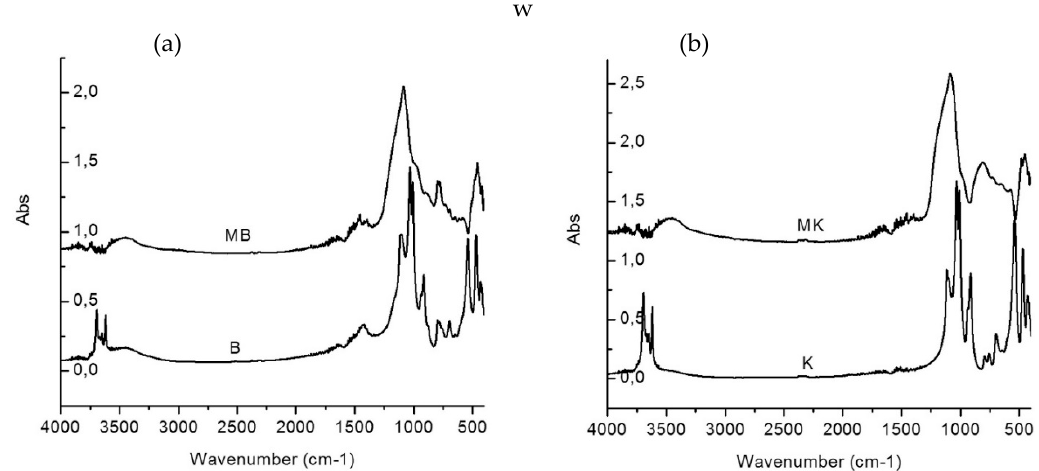
Figure 6. FTIR Spectra of ( a ) kaolin and ( b ) ceramic waste; MB = calcined ceramic waste, B = ceramic waste, MK = calcine kaolin, and K = kaolin.